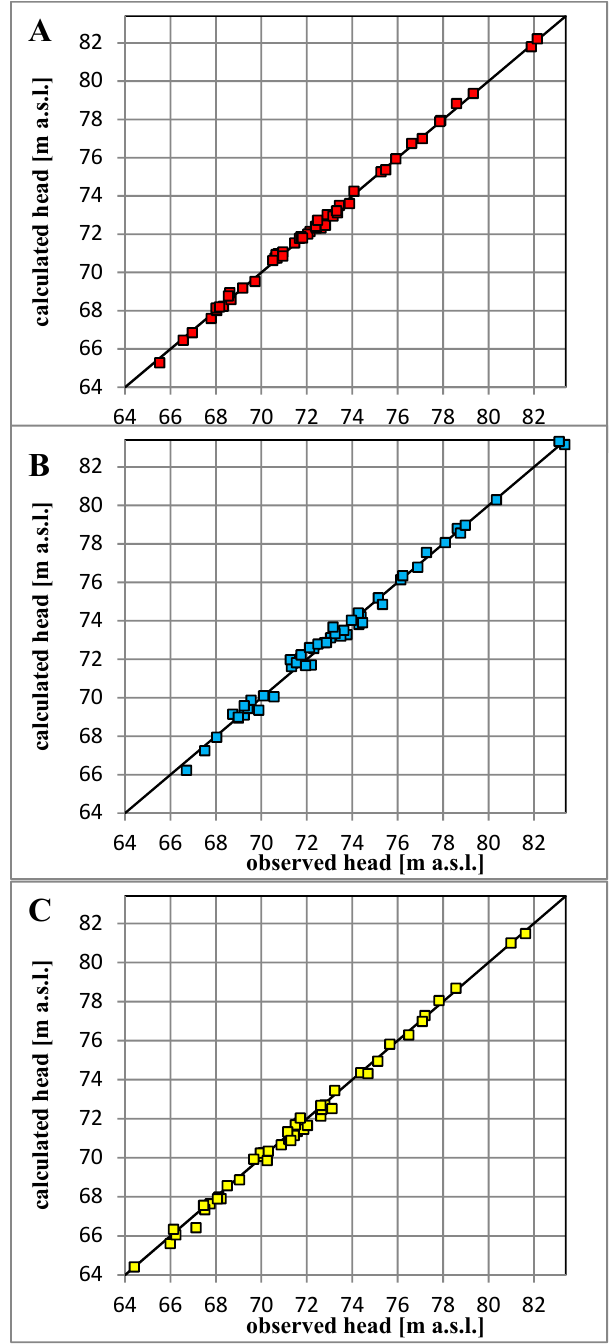
Figure 6. Groundwater model calibration diagram-calculated head vs observed head. ( A )—variant 1; ( B )—variant 2; ( C )—variant 3.